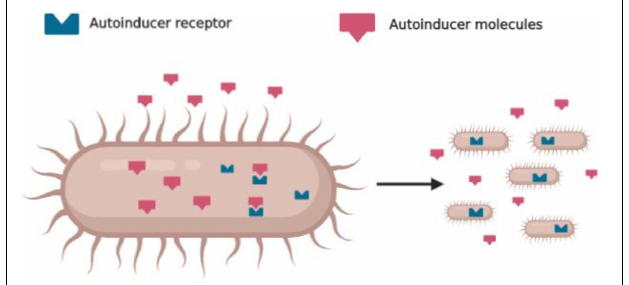
FIGURE 1 | Schematic representation of quorum sensing: bacteria produce autoinducers molecules and detect the same molecules with specific receptors that coordinate their